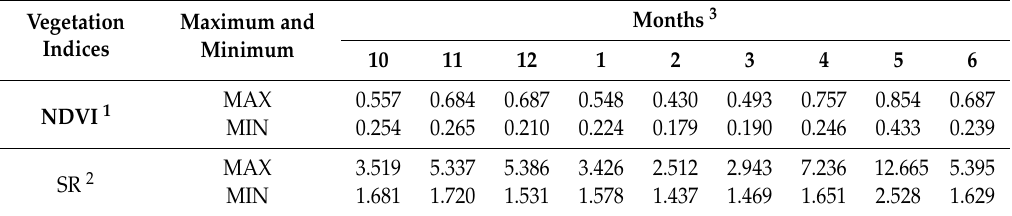
Table 1. NDVI and SR maximum and minimum values for winter wheat for each month of the growing season .